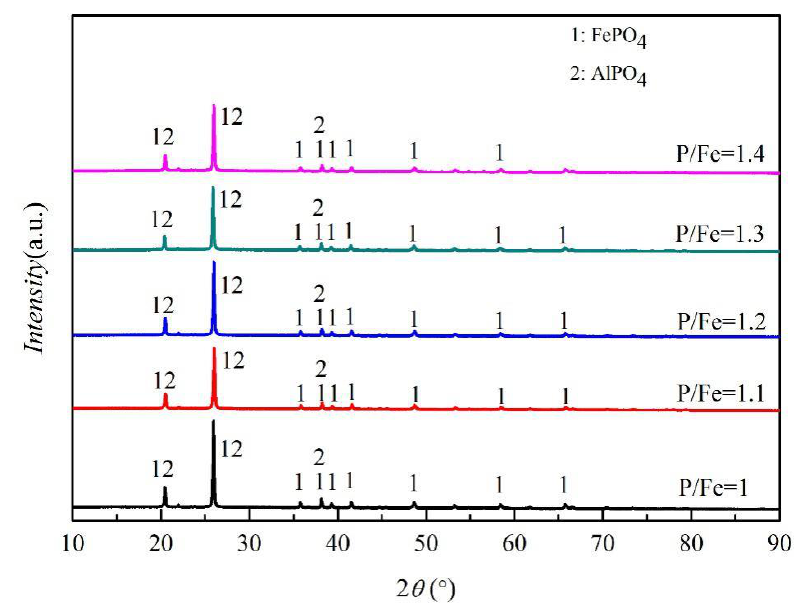
Figure 9. XRD pattern of samples at different molar ratios of P/Fe.